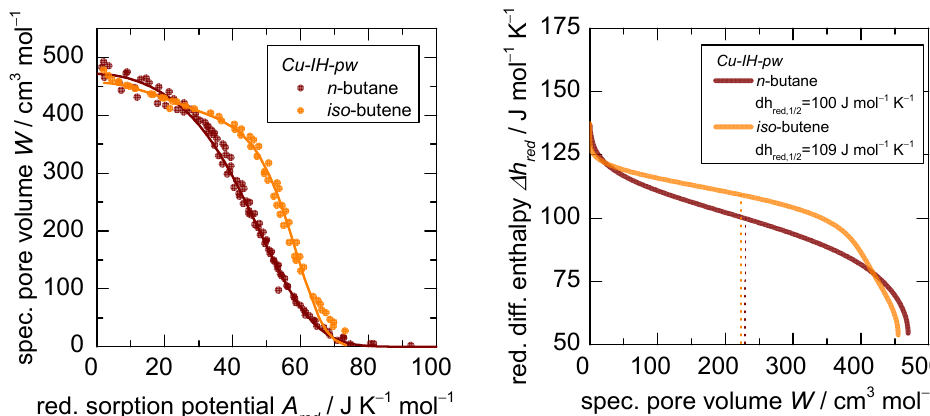
Figure 5. D-UAT plot ( left ) and reduced differential heat of adsorption dh red ( right ) after application of the UAT to the sorption of n -butane and iso -butene on Cu-IH-pw at 283 K, 298 K, and 313 K.